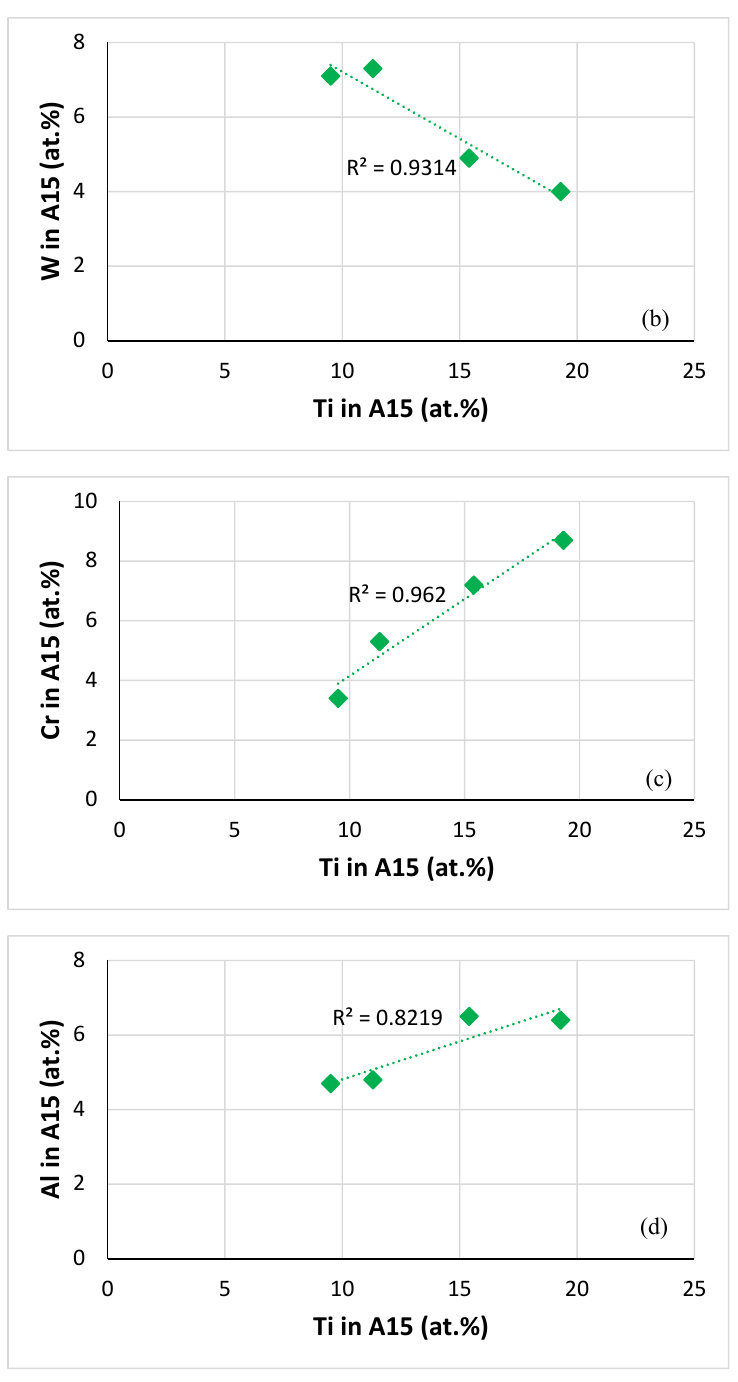
Figure 14. Data for the interdependence of Ti and solute concentrations in A15-Nb 3 X in the alloys JZ3 and JZ3+. ( a ) Ta versus Ti, ( b ) W versus Ti, ( c ) Cr versus Ti and ( d ) Al versus Ti.